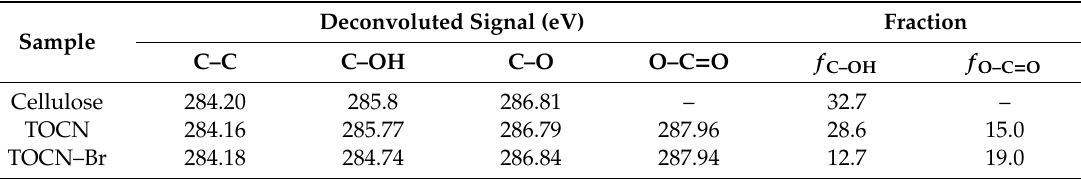
Figure 3. ESCA spectra (C1s) of ( a ) pristine cellulose, ( b ) TOCN, and ( c ) TOCN–Br. Table 1. Deconvolution data of various C1s groups from ESCA analysis.